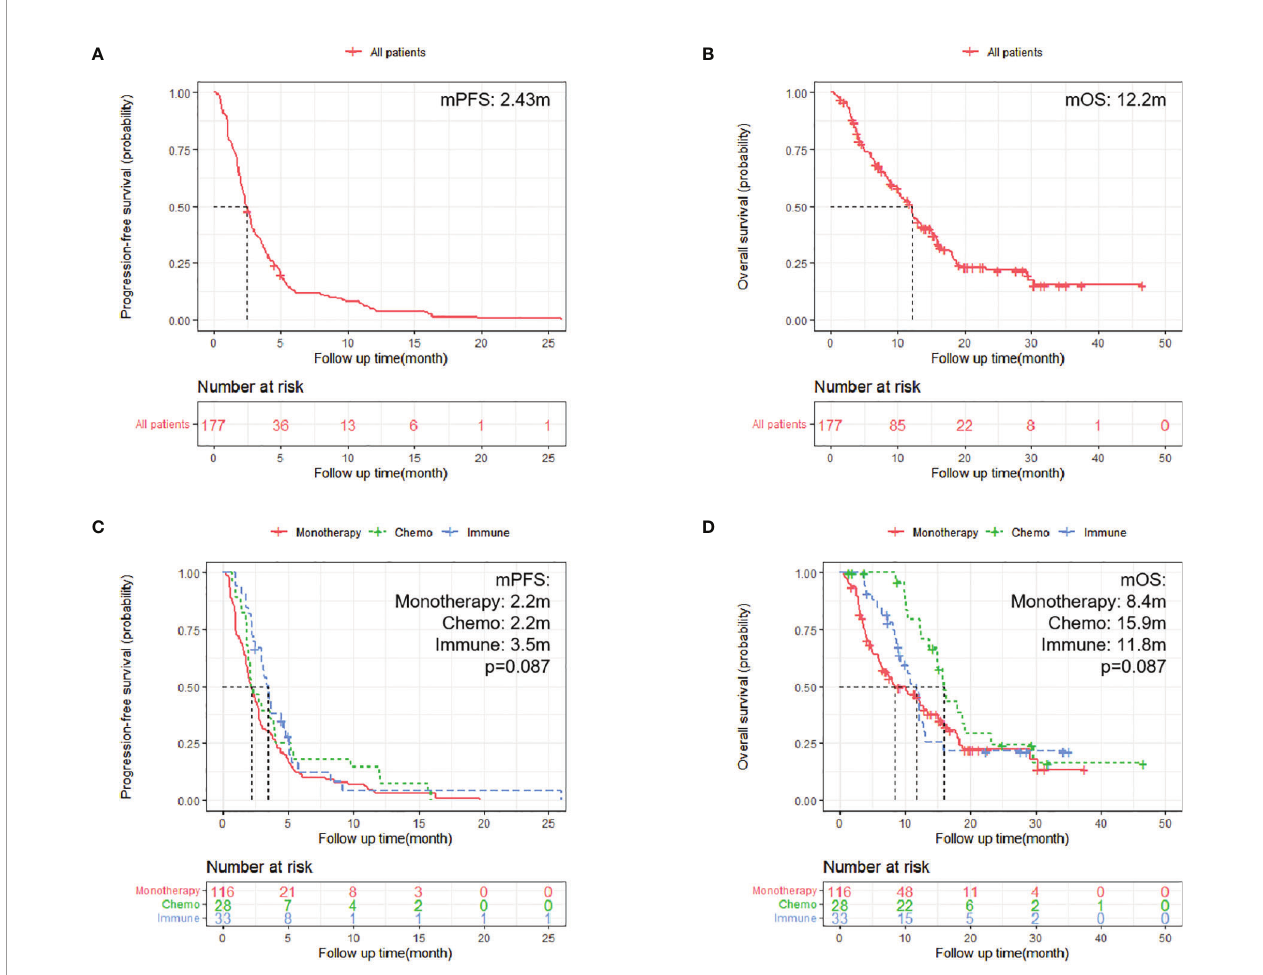
FIGURE 2 | Kaplan – Meier survival curves. (A, B) Kaplan – Meier survival curves of all patients on PFS and OS [ (A) PFS of all 177 patients; (B) OS of all 177 patients]; (C, D) Kaplan – Meier survival curves of different treatment patterns [ (C) PFS of patients in three groups, p = 0.087; (D) OS in patients in three groups, p =